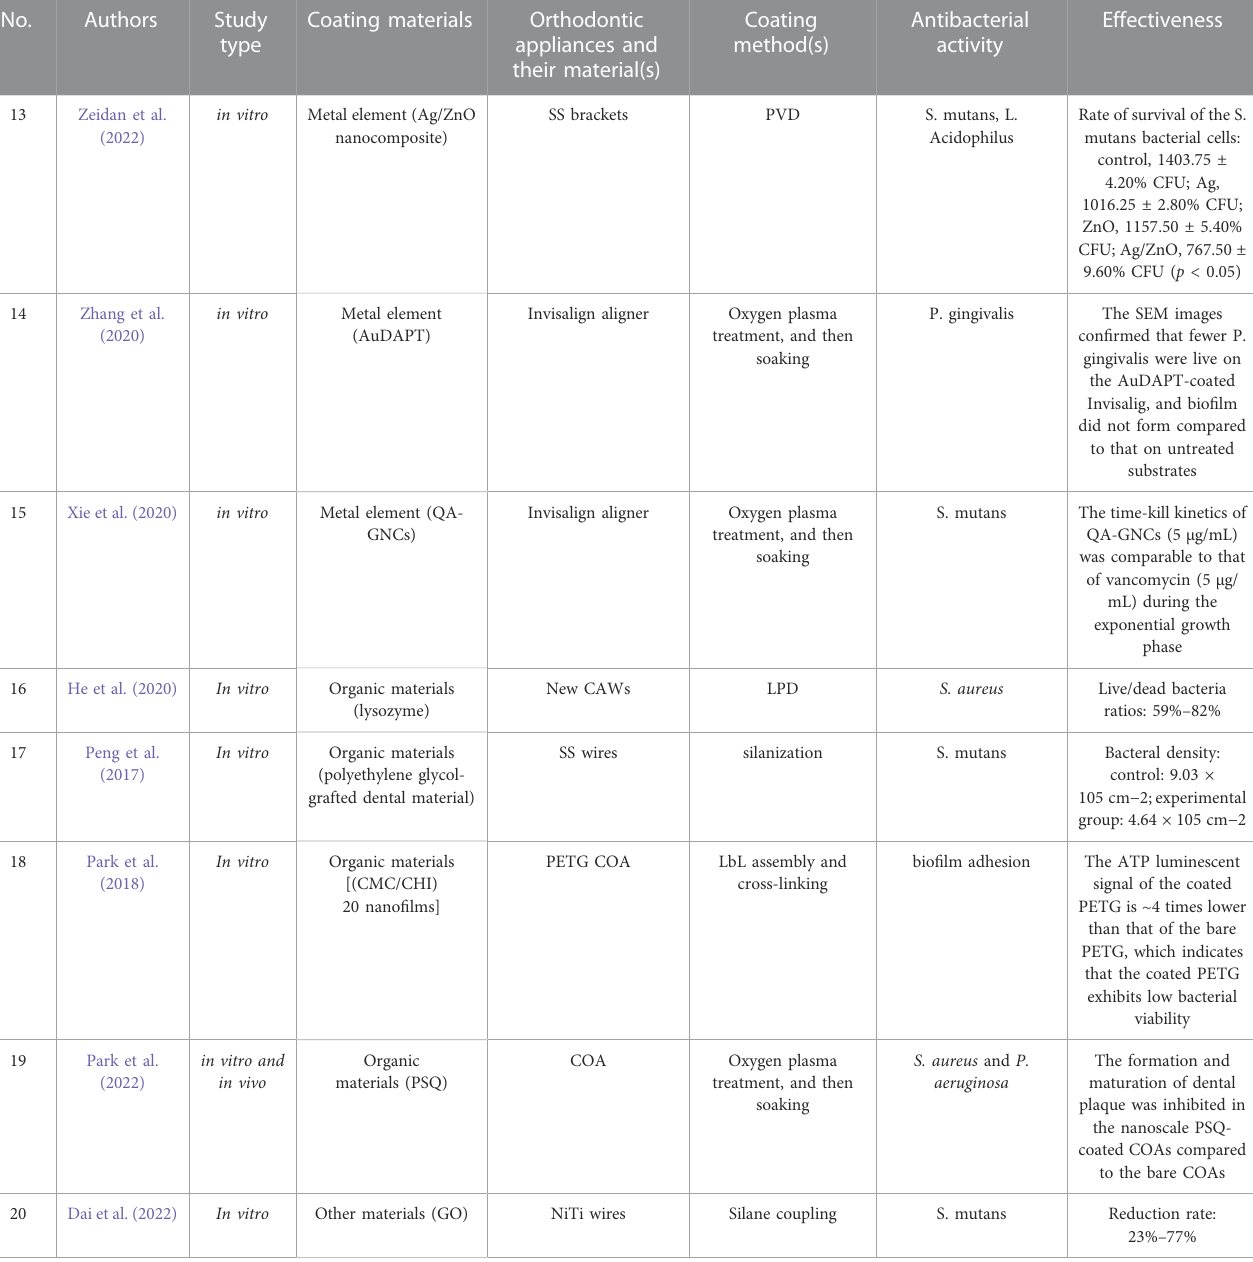
TABLE 1 ( Continued ) Comparison of the antibacterial characteristics for different coatings onto orthodontic appliances.